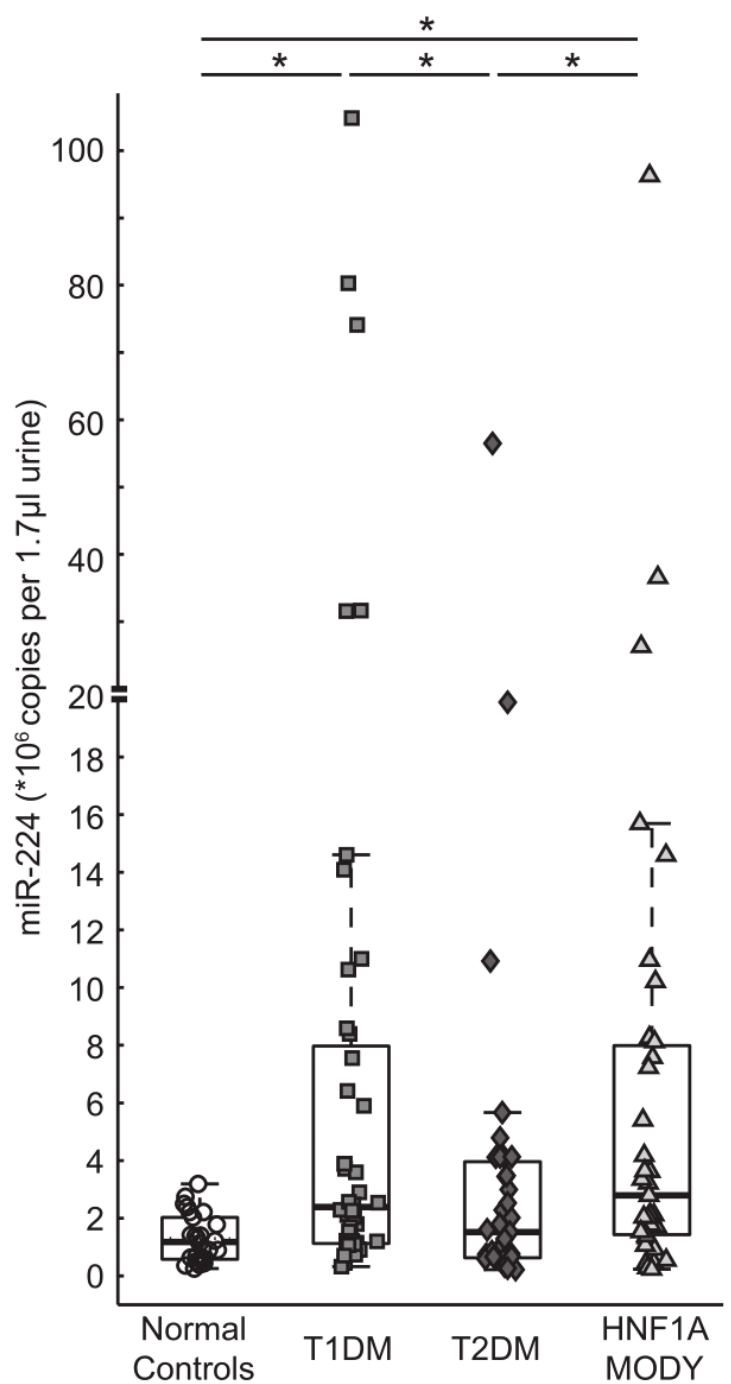
Figure 1. miR-224 levels detected in urine. Copies of miRNA per reaction were determined by quantitative qPCR in urine samples of T1DM ( n = 44), T2DM ( n = 36), HNF1A-MODY ( n = 38) and normal control ( n = 26) subjects. Box plots depict median and inter quartile range. The HNF1A-MODY mutation carriers had the highest median value of miR-224 and was significantly different from normal controls showing the lowest median value. In addition, the T1DM group had a higher median value than normal controls. miR-224 expression levels in the T2DM group were significantly lower than in T1DM group and the HNF1A-MODY mutation carriers but were similar to normal controls. ( * significant differences by Mann-Whitney